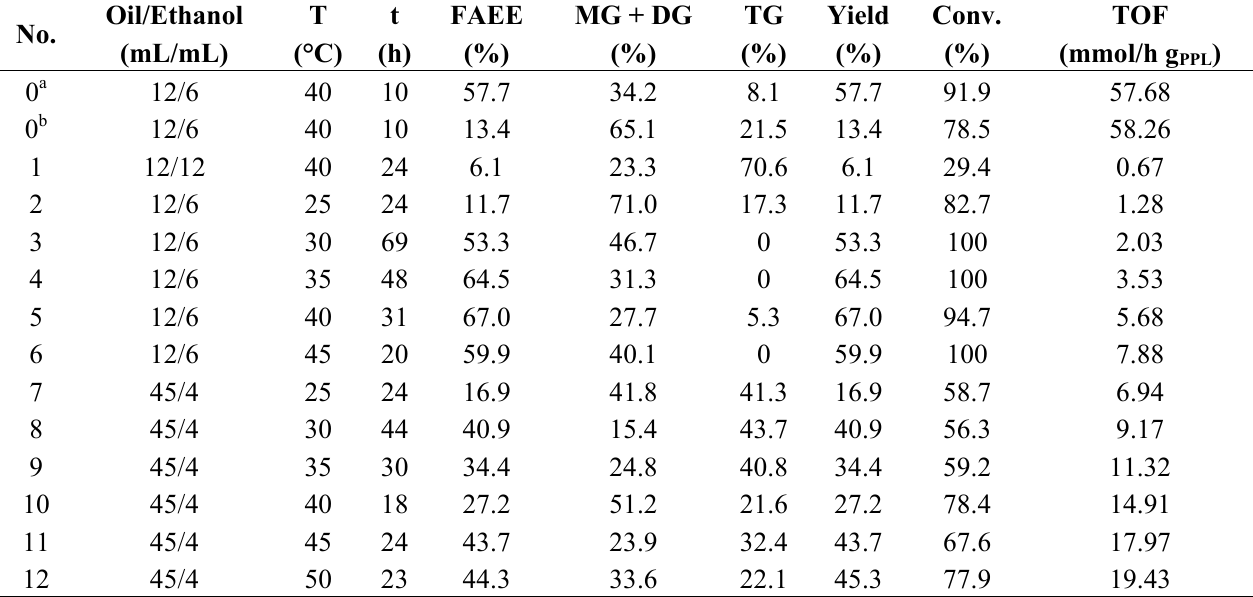
Table 1. Composition, yield, conversion and TOF of the biodiesel obtained in the transesterification reaction of sunflower oil with 0.01 g of free PPL and 0.038 g of immobilized PPL in 0.5 g of support with different ratios of oil/absolute ethanol working in standard condition pH = 12, and different reaction time and